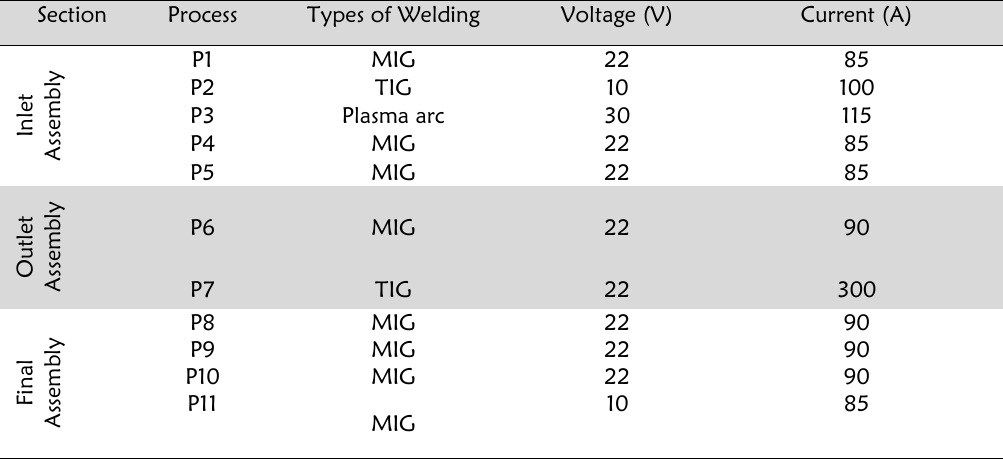
Table 2: Standard operating conditions of the welding